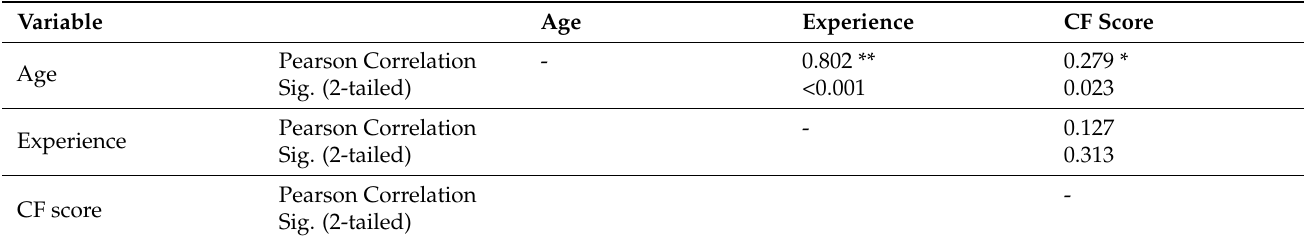
Table 3. Pearson Correlation for CF Scores with Age and